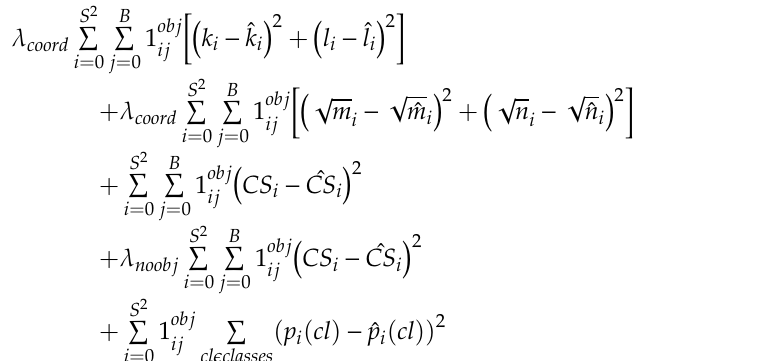
consists of 24 convolutional layers and 2 FC (Fully Connected) layers. To extract the features for the edge of the pothole, the filter used in convolution is constructed using the Laplacian mask. It is used to extract the edge of the pothole from all directions and carry out the fast calculations. It also approximates the second-order differential function of pixel values in the image. The loss function used for learning in YOLO uses a multi-part loss function [47]. Equation (1) represents the multi-part loss function. S represents the size of the grid cell. This is a matrix. Therefore, the total number of grid cells is represented by S×S , S 2 . CS stands for Confidence Score. Also, 𝜆 (cid:3030)(cid:3042)(cid:3042)(cid:3045)(cid:3031) is used as a balance parameter to balance the loss for the coordinates ( k , l , m , n ) and other losses. 𝜆 (cid:3041)(cid:3042)(cid:3042)(cid:3029)(cid:3037) is a balance parameter for the balance between a box with and without an object. This is used to maintain the balance because the number of cells with objects is relatively more than that of cells without objects in a general image.